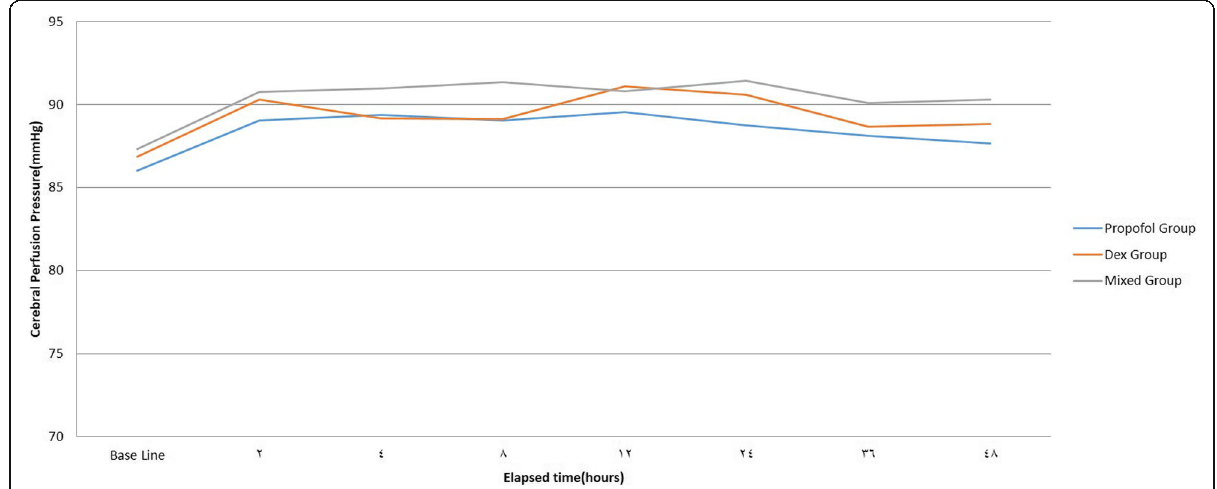
Fig. 7 Cerebral perfusion pressure changes in the studied groups